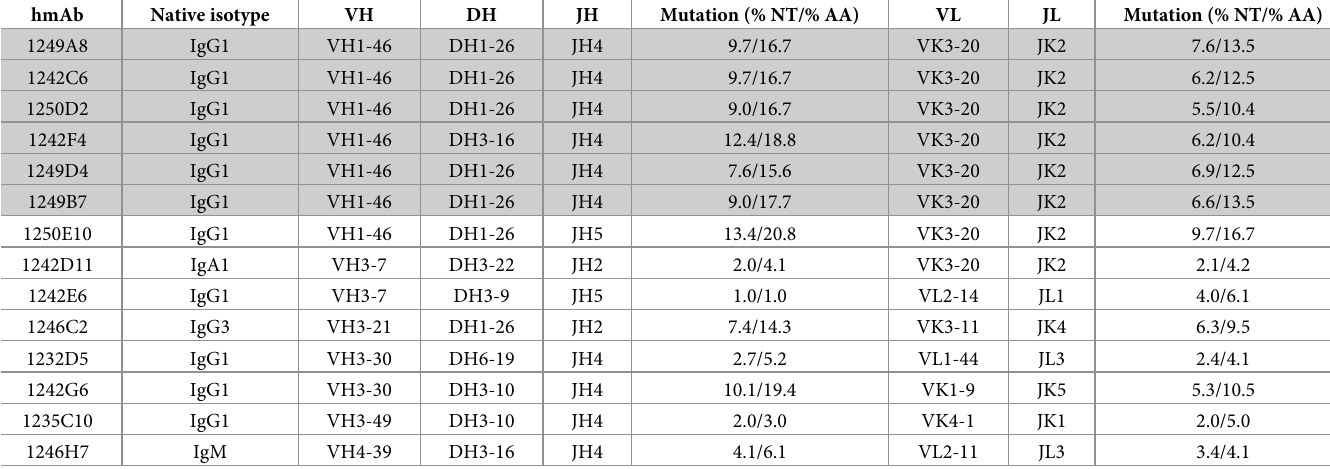
Table 1. Molecular characteristics of S2 specific hmAbs.